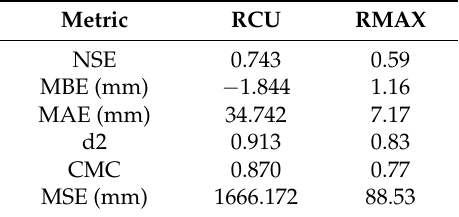
Table 9. Values of different performance evaluation metrics for the forecasted RCU by TOPSIS.